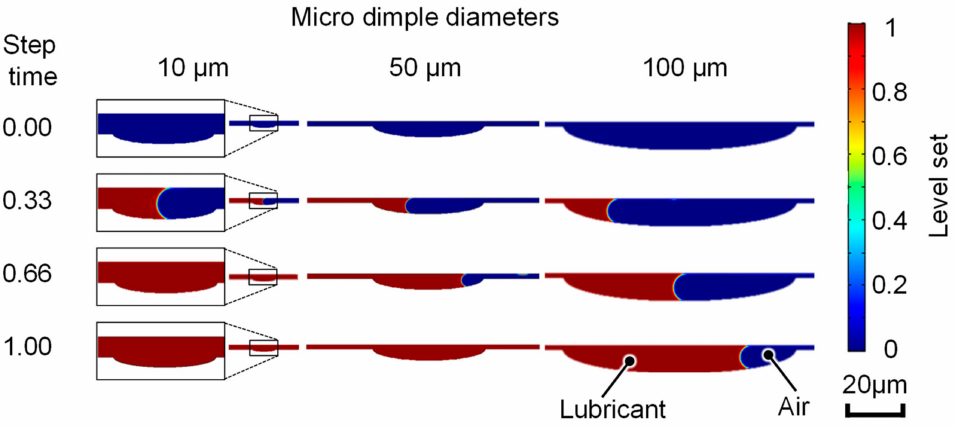
Figure 11. Comparison of the variations of the flow-in behavior of the lubricant at di ff erent time steps in the laminar two-phase flow analysis for di ff erent dimple diameters of 10 µ m, 50 µ m and 100 µ